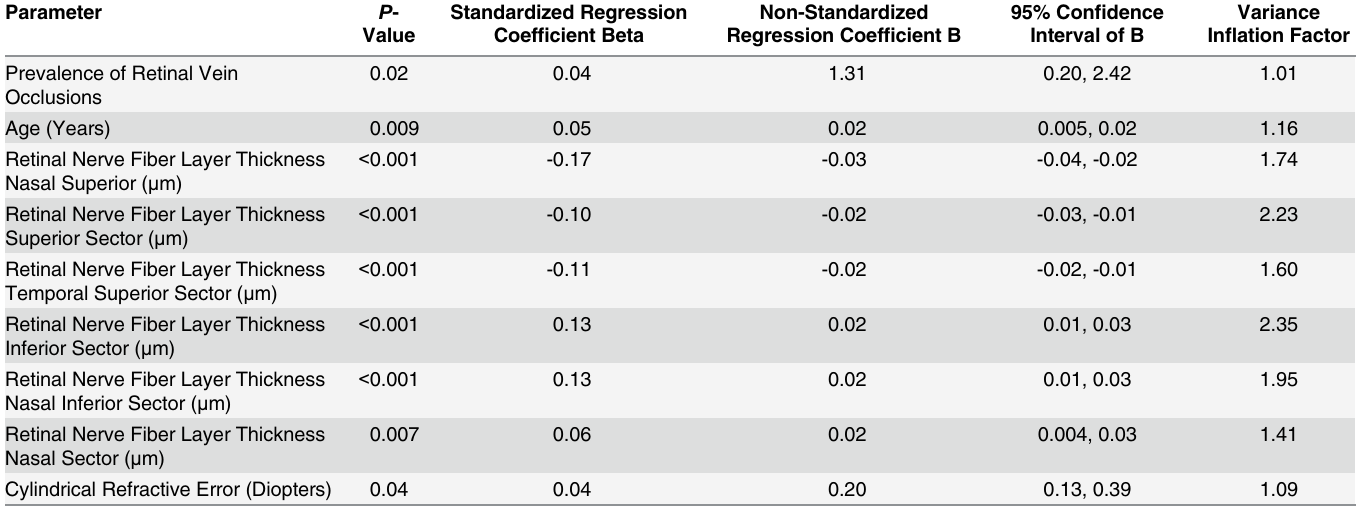
Table 2. Associations (Multivariate Analysis) between the Disc-Fovea-Angle and Ocular and Systemic Parameters in the Beijing Eye Study